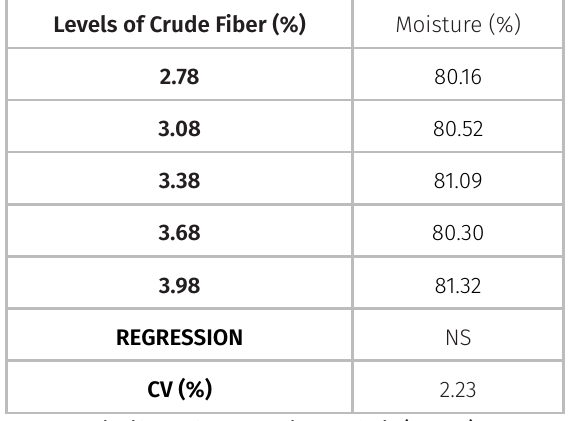
Table VII. Moisture of excreta of Japanese quails fed diets containing different levels of crude fiber. Levels of Crude Fiber (%)